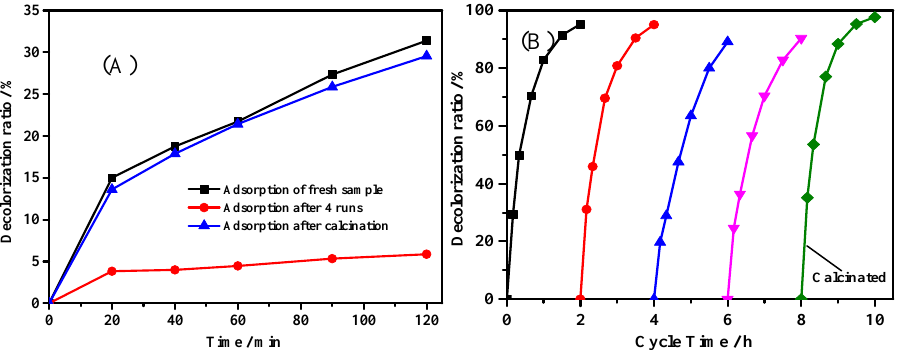
Figure 8. ( A ) Adsorption curves of fresh sample, the sample after 4 tests, and the sample calcinated after 4 tests, ( B ) repeated tests of Fe 2 O 3 @CC and the recovery of activity after calcination at 300 °C for 1 h.